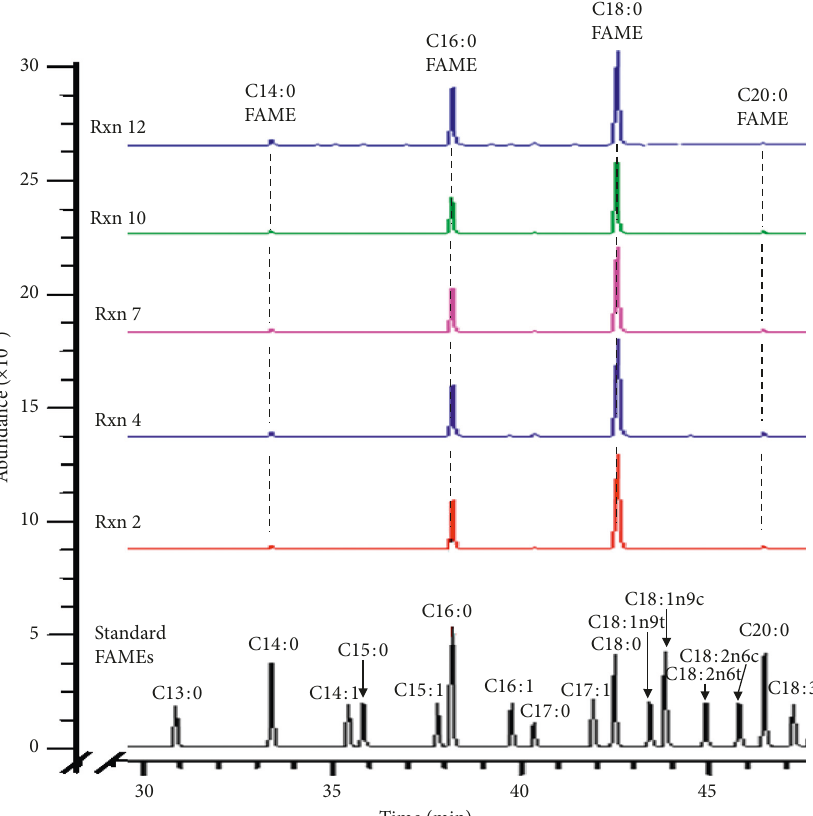
Figure 2: GC-mass chromatograms of methyl-esterified products (FAMEs) from zinc stearate.